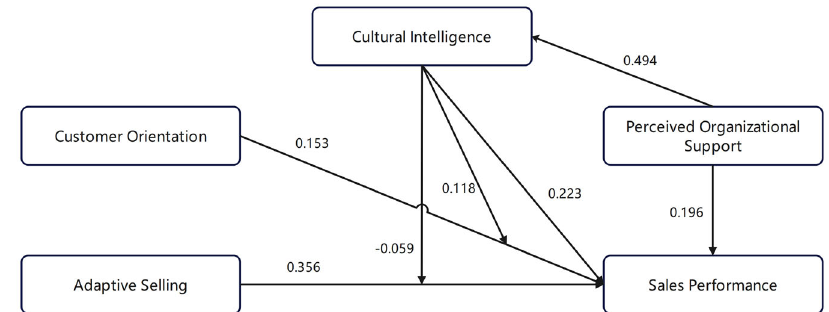
Fig. 2 Path coef fi cients of the structural model.